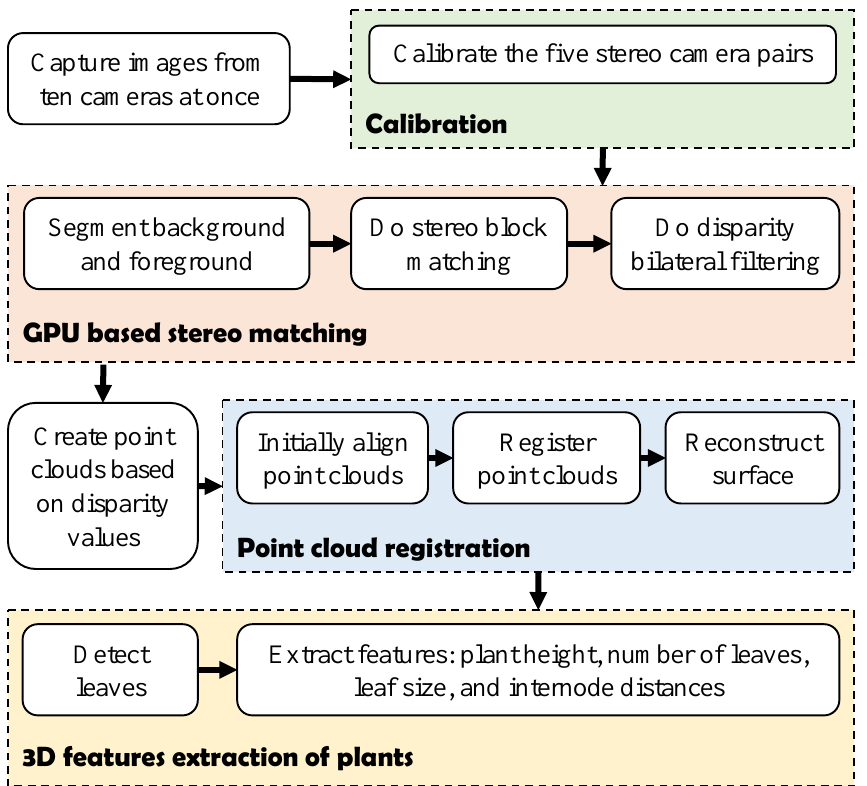
Figure 3. Block diagram representation of the software